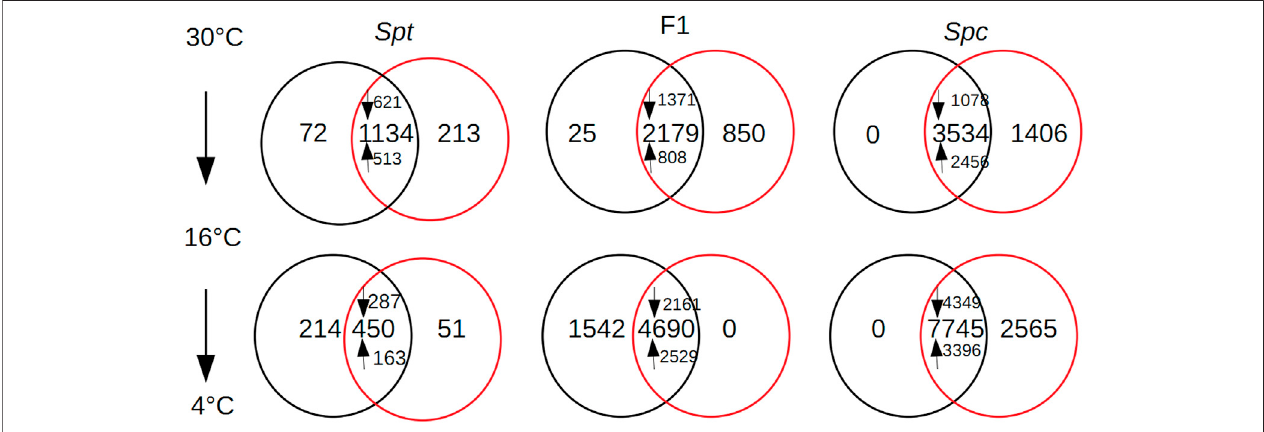
FIGURE 2 | Venn diagram shown for the shared number of differential expression transcripts between the edgeR (red) and DESeq2 (black) for Sphagneticola trilobata ( Spt ), the F1 hybrid, and S. calendulacea ( Spc ) under three gradient temperature chilling from 30 to 4 ° C; up-regulated and down-regulated transcripts were marked using upwards arrows and downwards arrows,